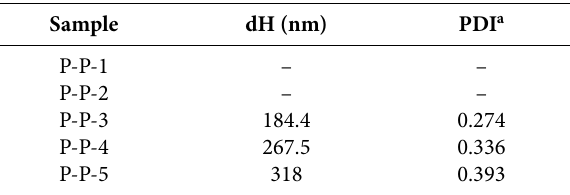
Table 2. Average hydrodynamic diameters and polydipersity index of the synthesized PEGMA particles Sample